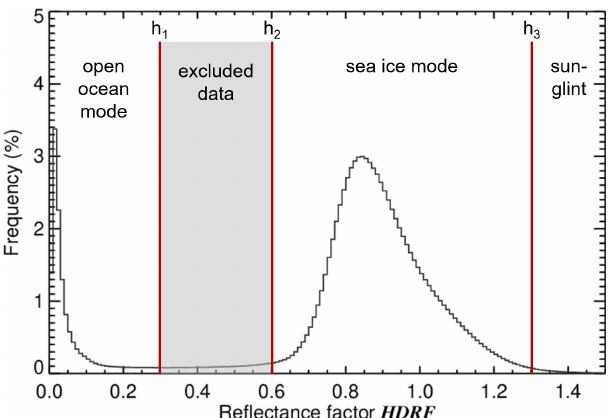
Figure 2. Frequency distribution of the observed HDRF for all di- rections and all images. The three vertical red lines indicate the thresholds of h 1 = 0 . 3, h 2 = 0 . 6, and h 3 = 1 . 3 applied in the sea ice mask